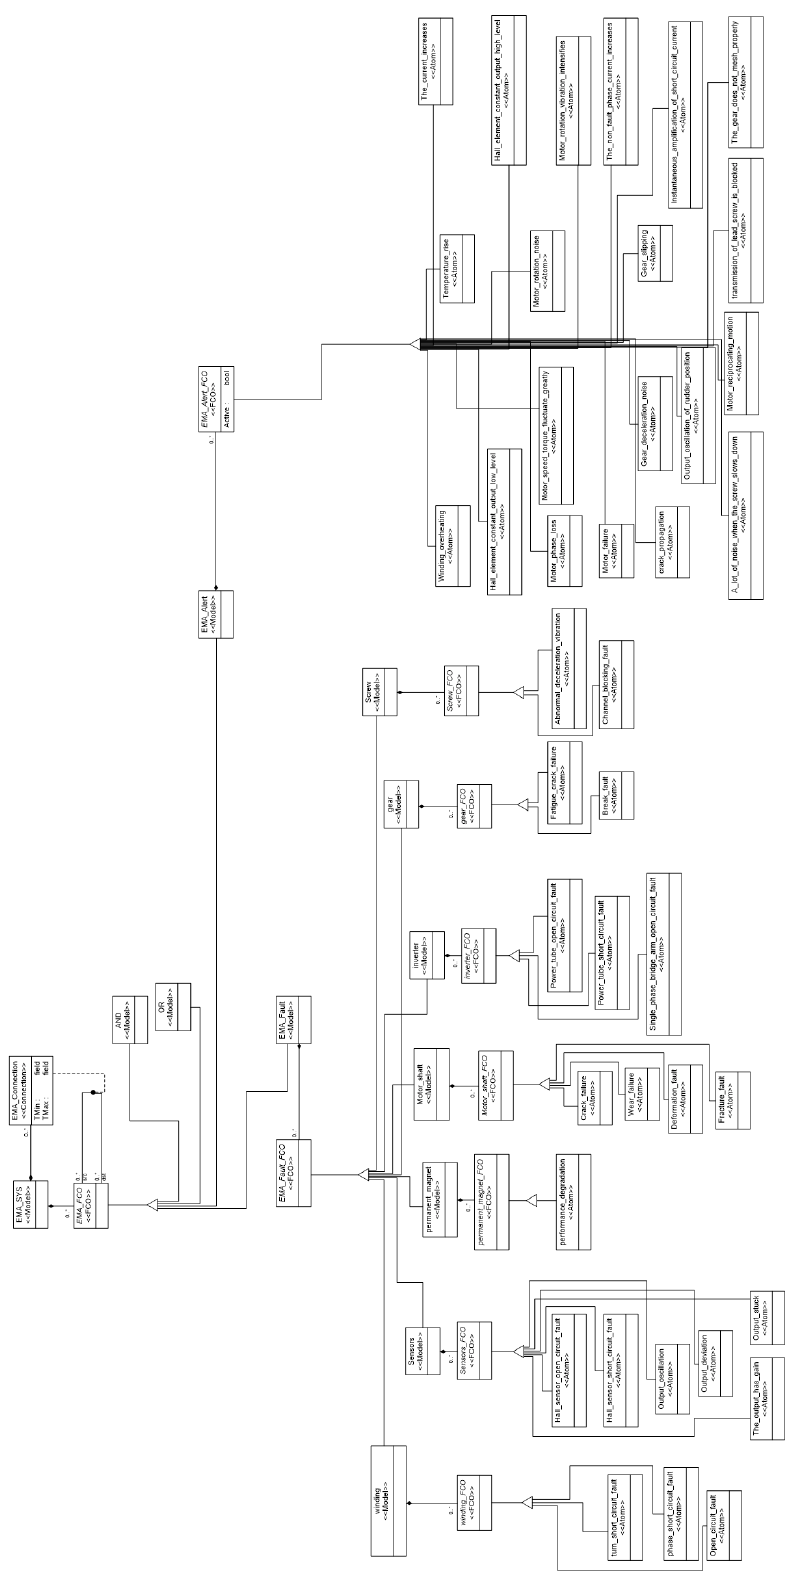
Figure A1. The metamodel of EMA in the general modeling environment (GME).